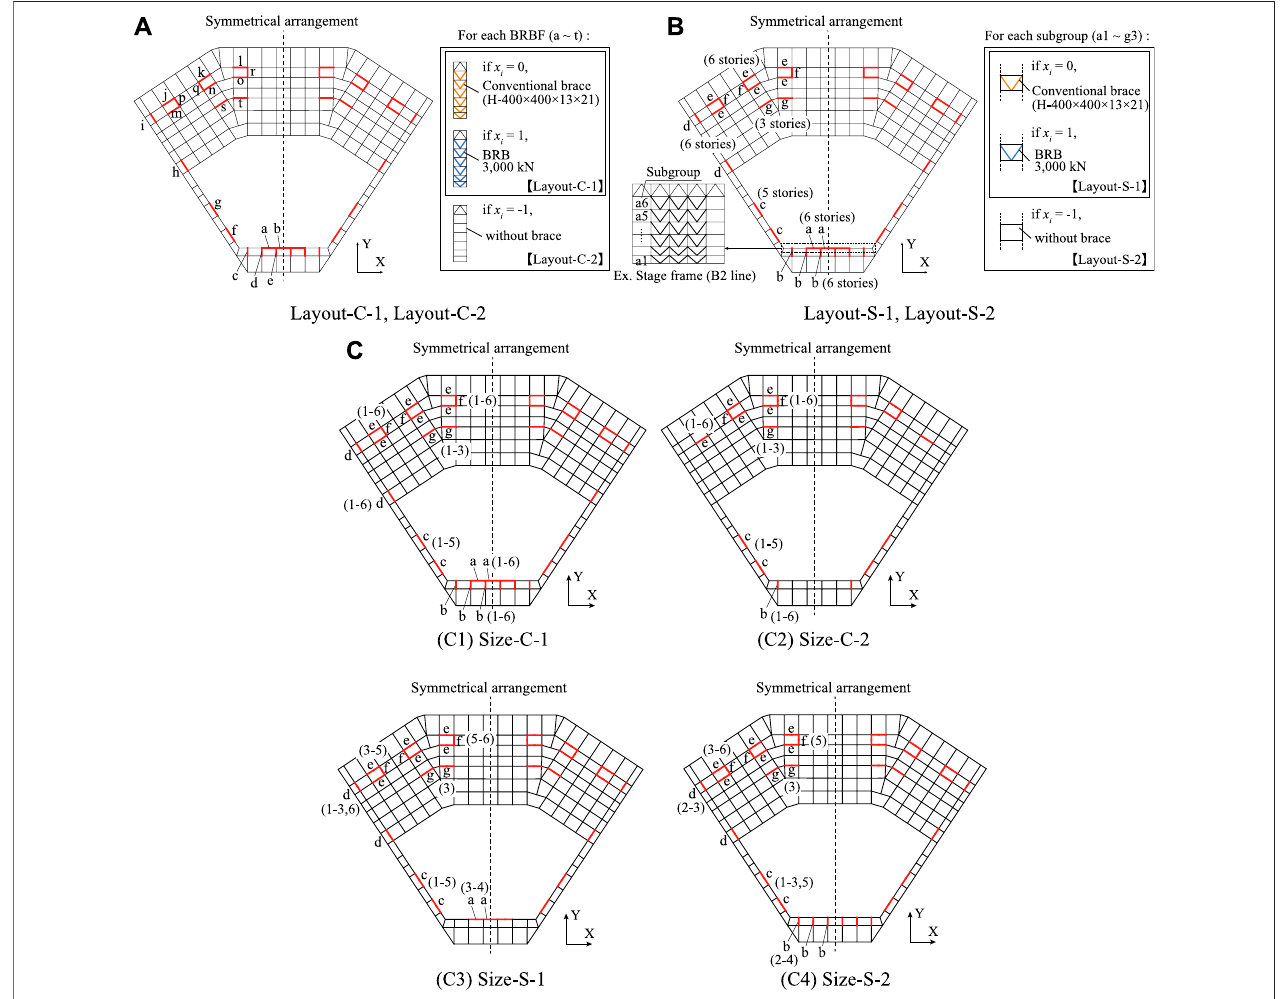
FIGURE 7 | De fi nitions of the design variables of the GRSA-based seismic optimizations: (A) Layout optimization for each BRBF, (B) Layout optimization for each group, (C) Size optimization.